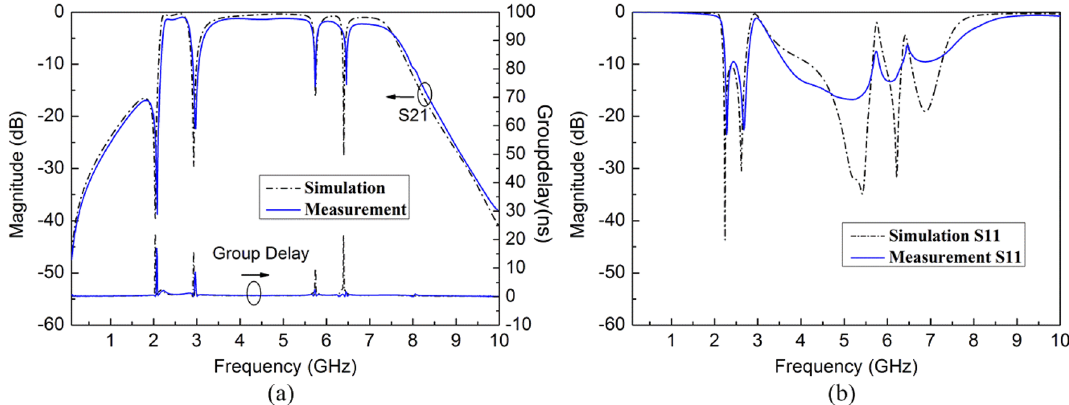
Figure 1. The simulation and measurement results of the proposed filter, ( a ) S21 and group delay ( b ) S11.